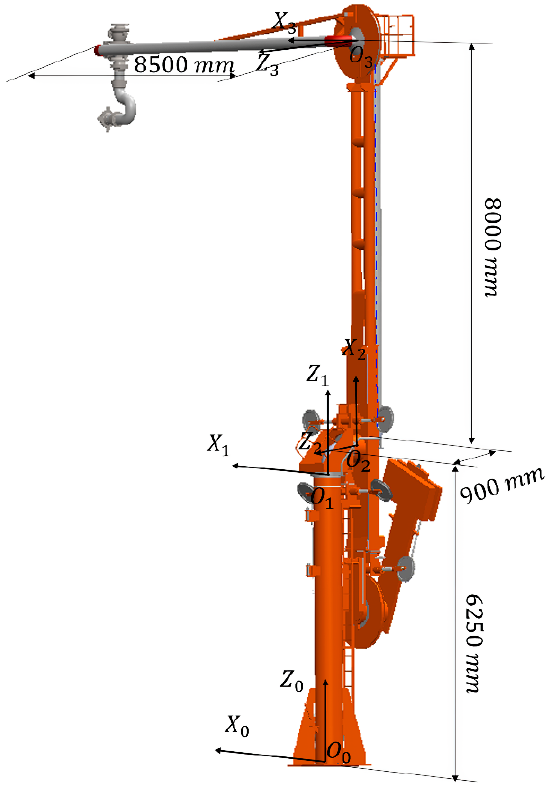
Table 4. D–H parameter table. Link ( 𝒊 )